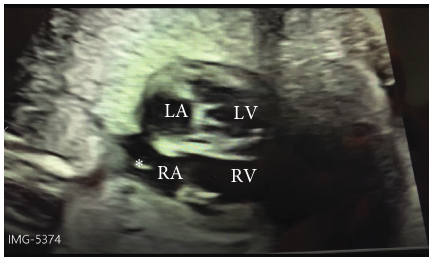
Figure 2: A 4-chamber fetal ECHO showing a 4 × 6 mm echogenic mass in the right atrium near the inferior vena cava suggestive of Chiari